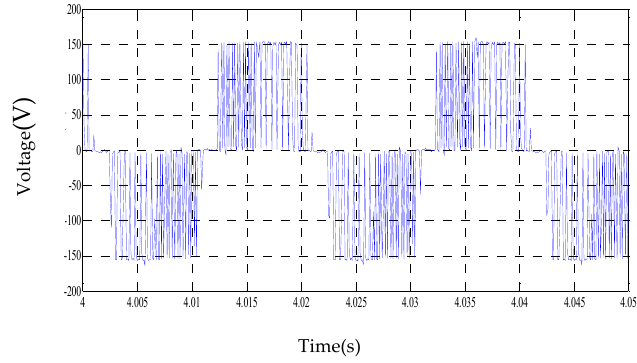
Figure 3. Principle of the SPWM two level control strategy.